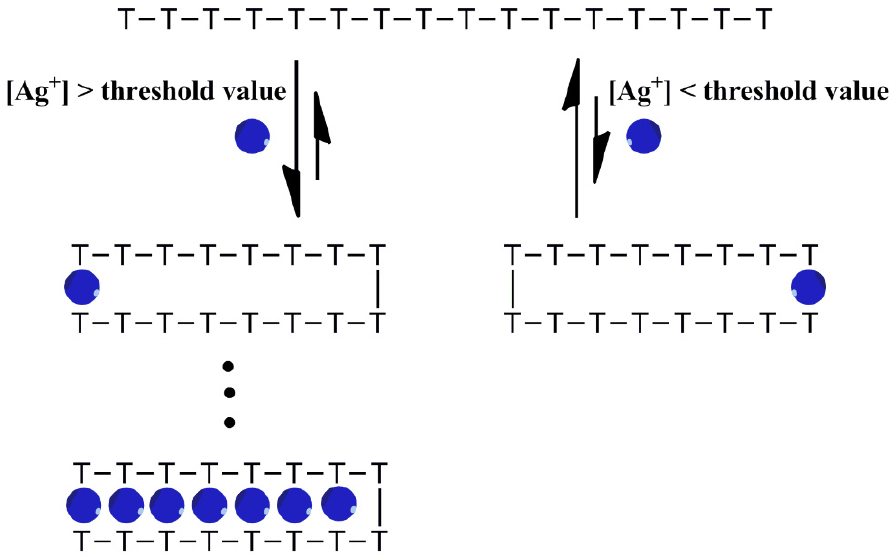
Figure 6. Schematic representation of positively cooperative formation of Ag + -bridged intramolecular T-Ag + -T base pairs in polyT oligonucleotides.